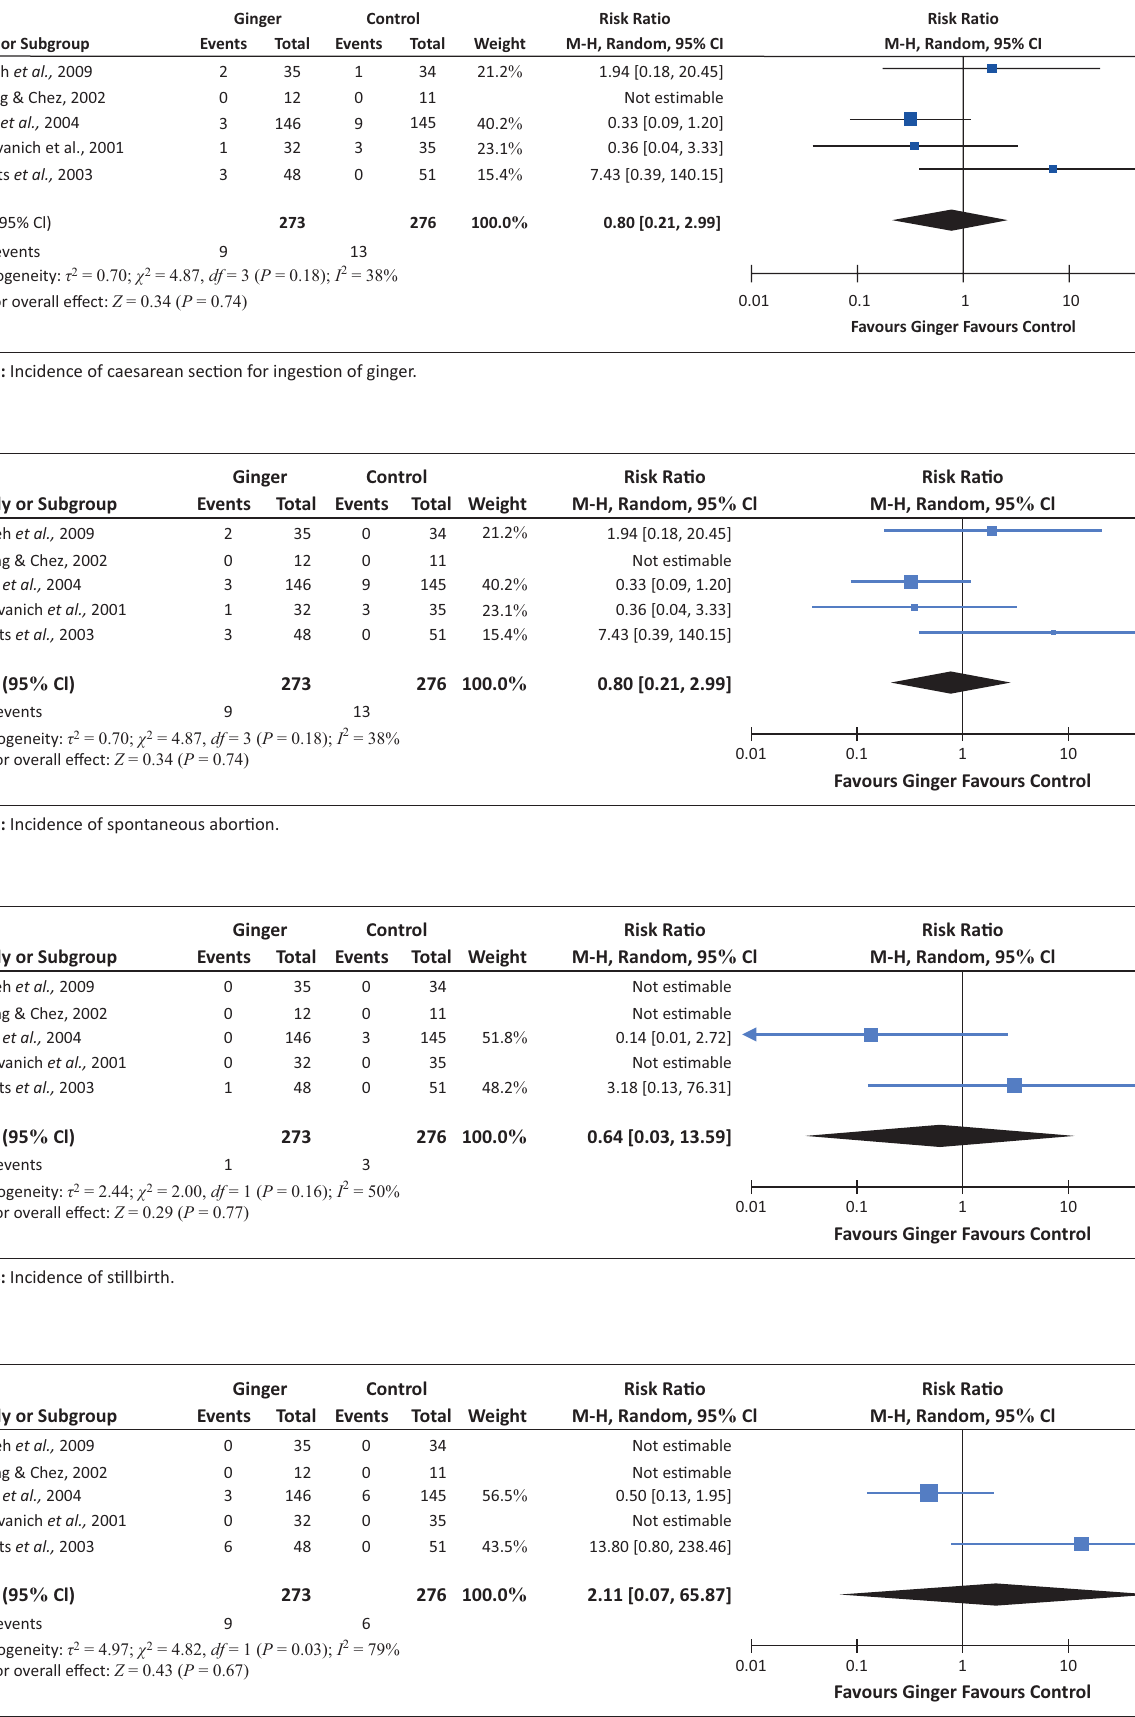
FIGURE 5: Congenital